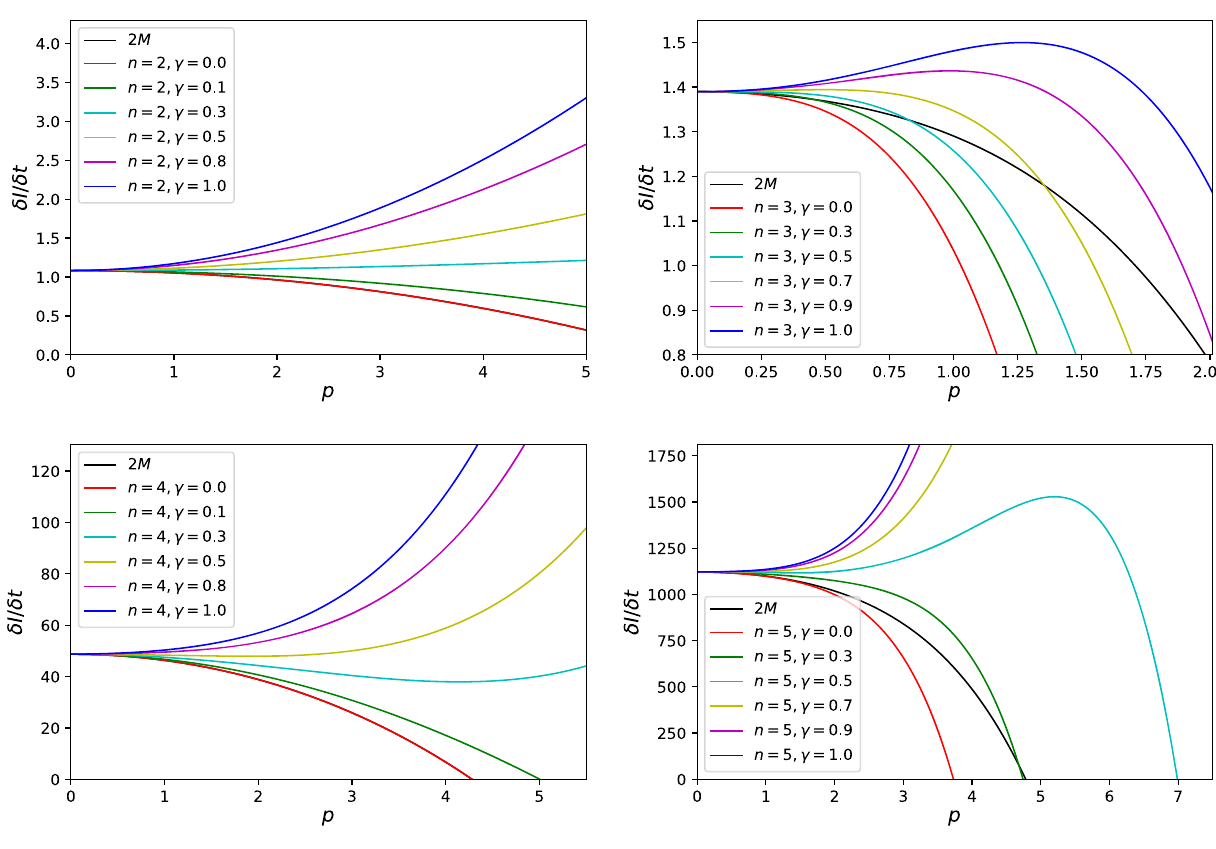
Fig. 5 δ I δ versus p for the purely magnetic black holes with single t horizon. The black line on each plot is the 2 M line. For the n = 2 and n = 4 cases, the black lines coincide with the red lines. The parameters